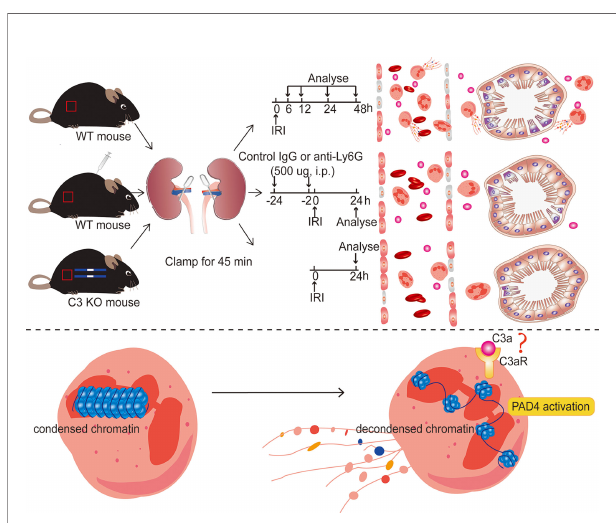
FIGURE 10 | Diagram of the underlying mechanism in renal IRI-induced AKI. Inhibiting NET formation by neutrophils depletion using anti-Ly6G (1A8) or C3 KO signi fi cantly ameliorated the resultant renal injury. In ischemic AKI, there is increased cleavage of C3 to C3a, which probably binds to C3aR on the surface of neutrophils and then activates PAD4, leading to the release of